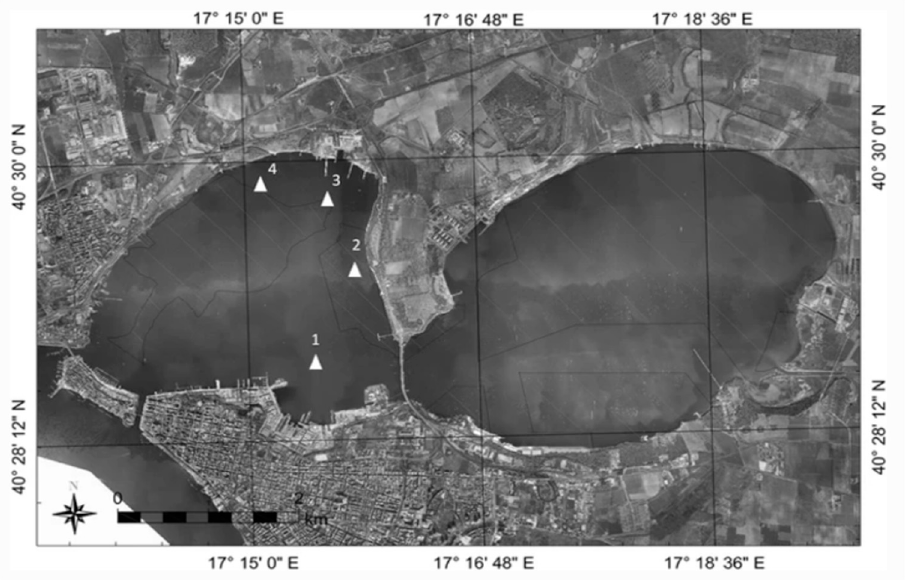
Figure 15. Location of the sampling stations [69]. Table 6. M ean values of As, Cd, Cu, Hg and Pb (mg/kg wet weight) and wet/dry ratio in soft tissues of marine organisms ( n = 3; S.D. range = 7–12%) .